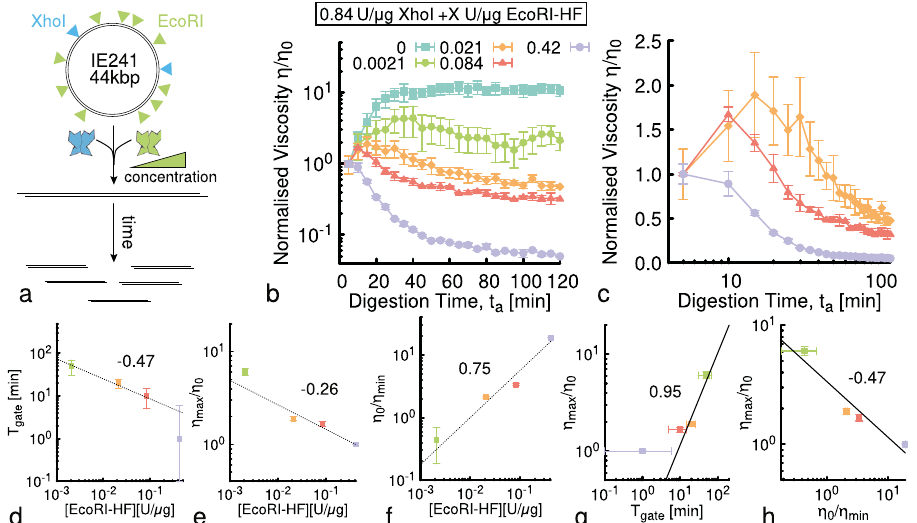
Fig.5|Time-dependentandnon-monotonicrheologyofentangledDNA fl uids. a Our fl uid comprises 44kbp circular DNA (IE241) and two different REs that cut the DNA twice (XhoI) or 10 times (EcoRI). The green ramp indicates that we vary the concentration of EcoRI while keeping the DNA and XhoI concentrations fi xed. b Normalised viscosity versus digestion time for solutions of 1.4mg/ml circular DNA undergoing architectural conversion by a fi xed concentration of XhoI (0.84U/ μ g) and fi ve different EcoRI concentrations (listed in the legend). Fluids exhibit initial rise in viscosity, due to XhoI-driven linearisation of the circular DNA, followed by a decrease, due to fragmentation by EcoRI. The maximum increase in viscosity, η max / η 0 ,and timeatwhichtheviscositystarts todecrease,i.e., thegating